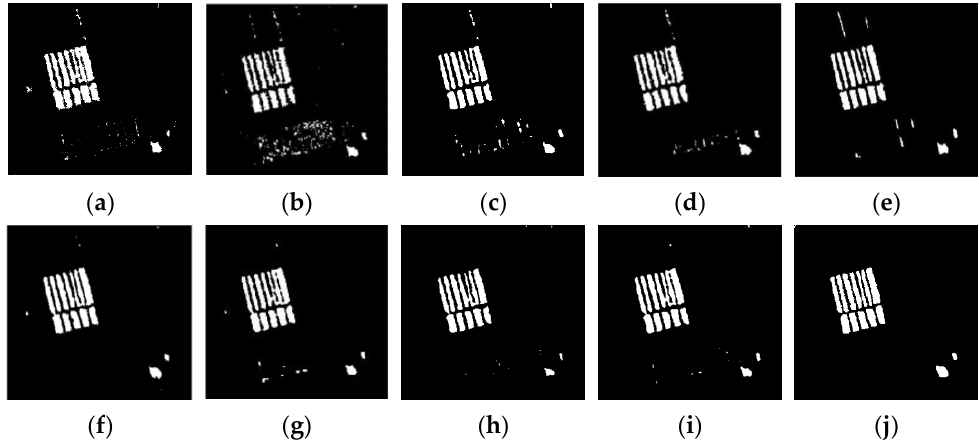
Figure 17. Change detection results of different methods used for the Farmland-A dataset. ( a ) DBN;